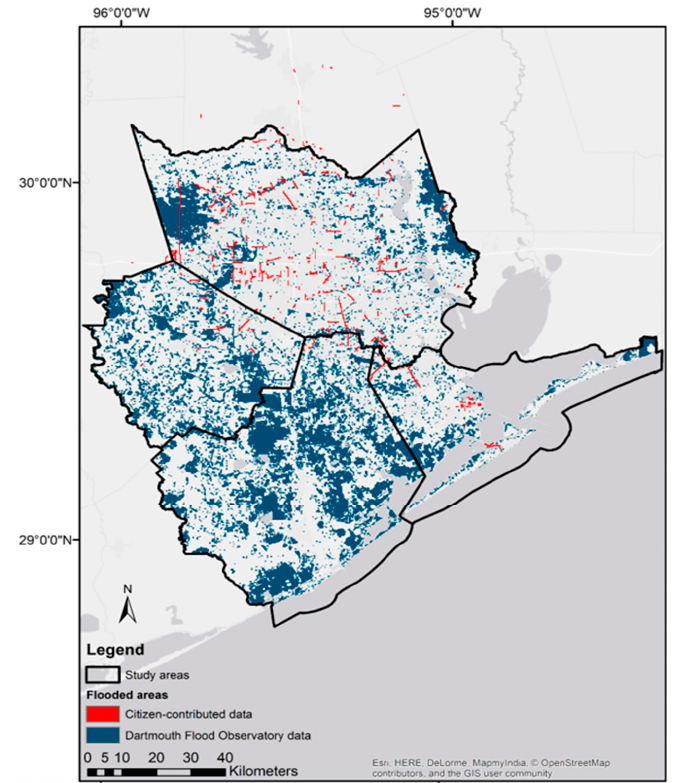
Figure 2 . Hurricane-Harvey-induced flooding map areas. Figure 2. Hurricane-Harvey-induced flooding map